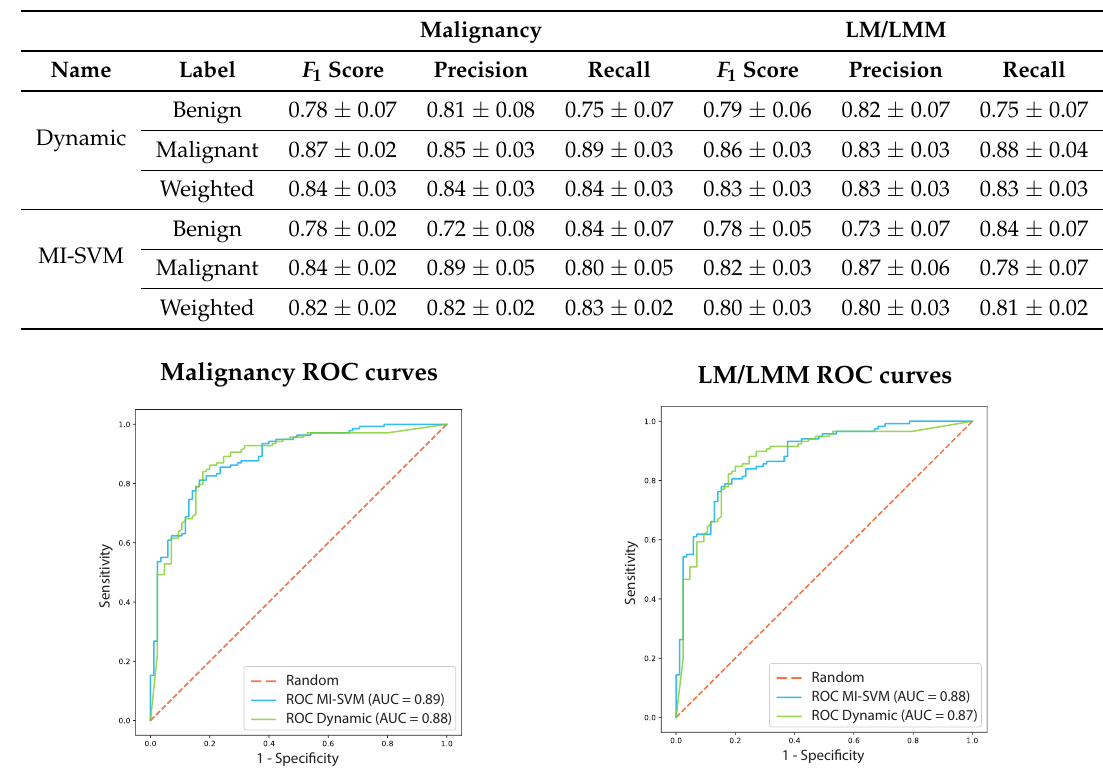
Table 7. Detailed results for the patient-level classification for the Decision method based on a Dynamic threshold and MIL based on the MI-SVM assumption. The table provides the F 1 score, Precision, and Recall for the benign and malignant classes with these methods.